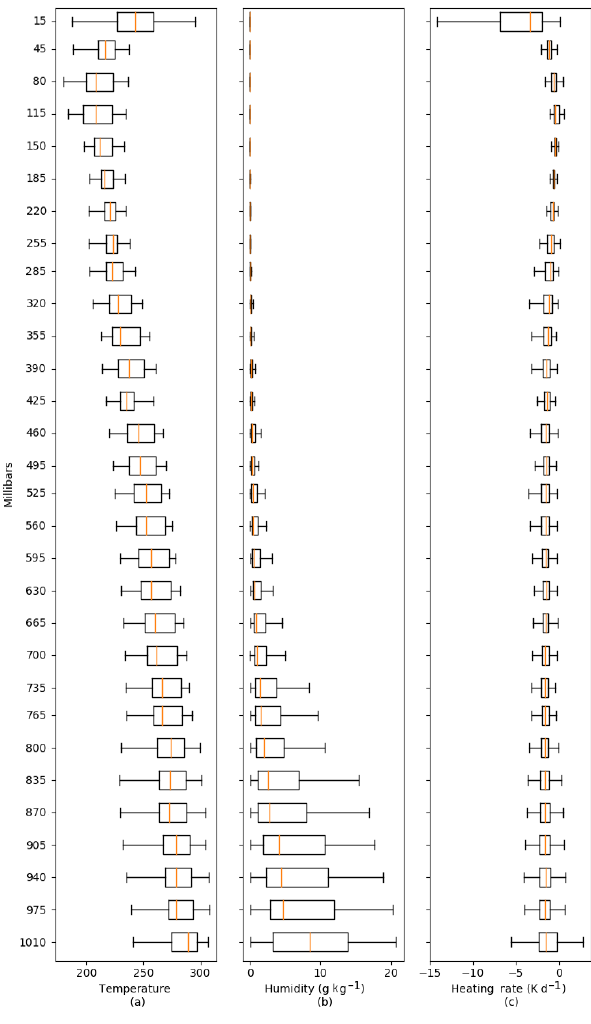
Figure 1. (a, b) ERA-Interim air temperature (K) and humidity (gkg − 1 ) statistics. (c) Longwave radiative rates (Kd − 1 ) calculated using RRTMG. Vertical axis is pressure in pascals